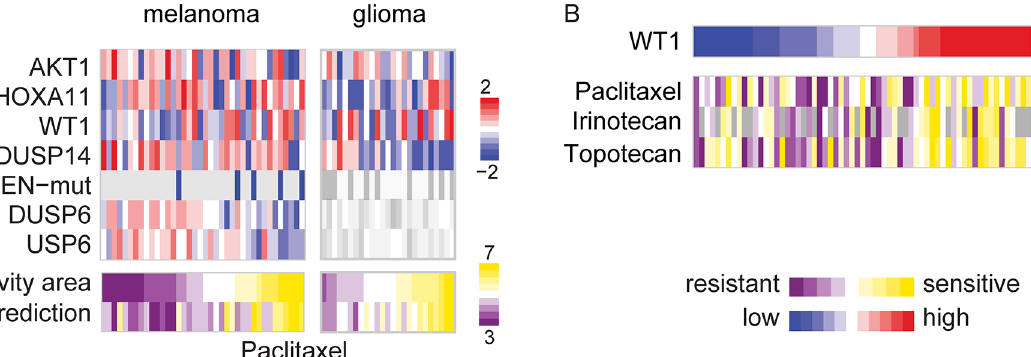
Fig 6. Example of predictive model for melanoma and glioma samples. A. CHER ’ s model for drug sensitivity to paclitaxel. Each vertical bar represents a data of a sample. All features are gene expression profiles except PTEN, which is a mutation profile feature (blue bars represents samples with mutations). AKT1 and WT1 are predictive for both melanoma and glioma. PTEN-mut, DUSP6 and USP6 are predictive features specific for melanoma whereas DUSP14 is specific for glioma. The greyed out heatmaps represents those features are not predictive for the samples. The predictions are obtained from leave-one-out procedure with the final selected features. B. Expression of WT1 is predictive of the cytotoxic drugs paclitaxel, irinotecan and topotecan, which likely due to IGF1-R